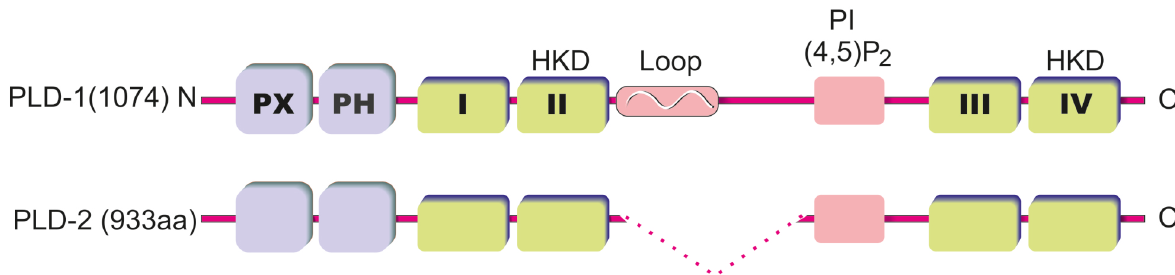
Figure 1. Domain structure of mammalian phospholipase D (PLD) isoforms. The PLD isoforms PLD1 (1074 amino acids) and PLD2 (933 amino acids) contain N -terminal